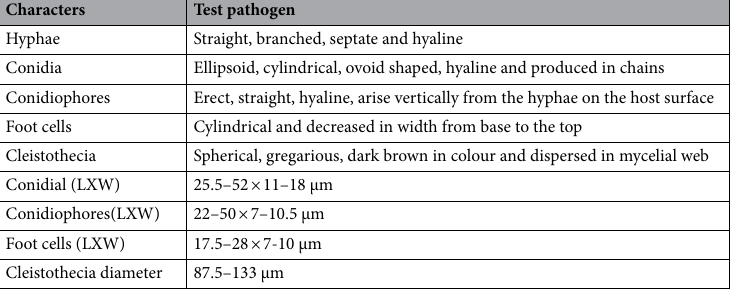
Table 1. Microscopic observations of powdery mildew causing fungal